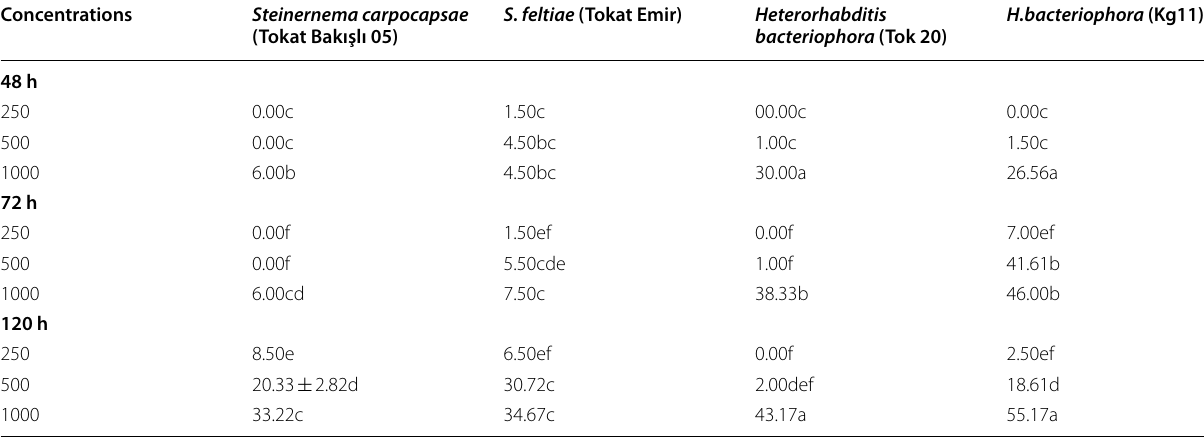
F 15.3 23, 48,104 and 71 for 48, 72, 120 h, respectively. P < 0.01 =